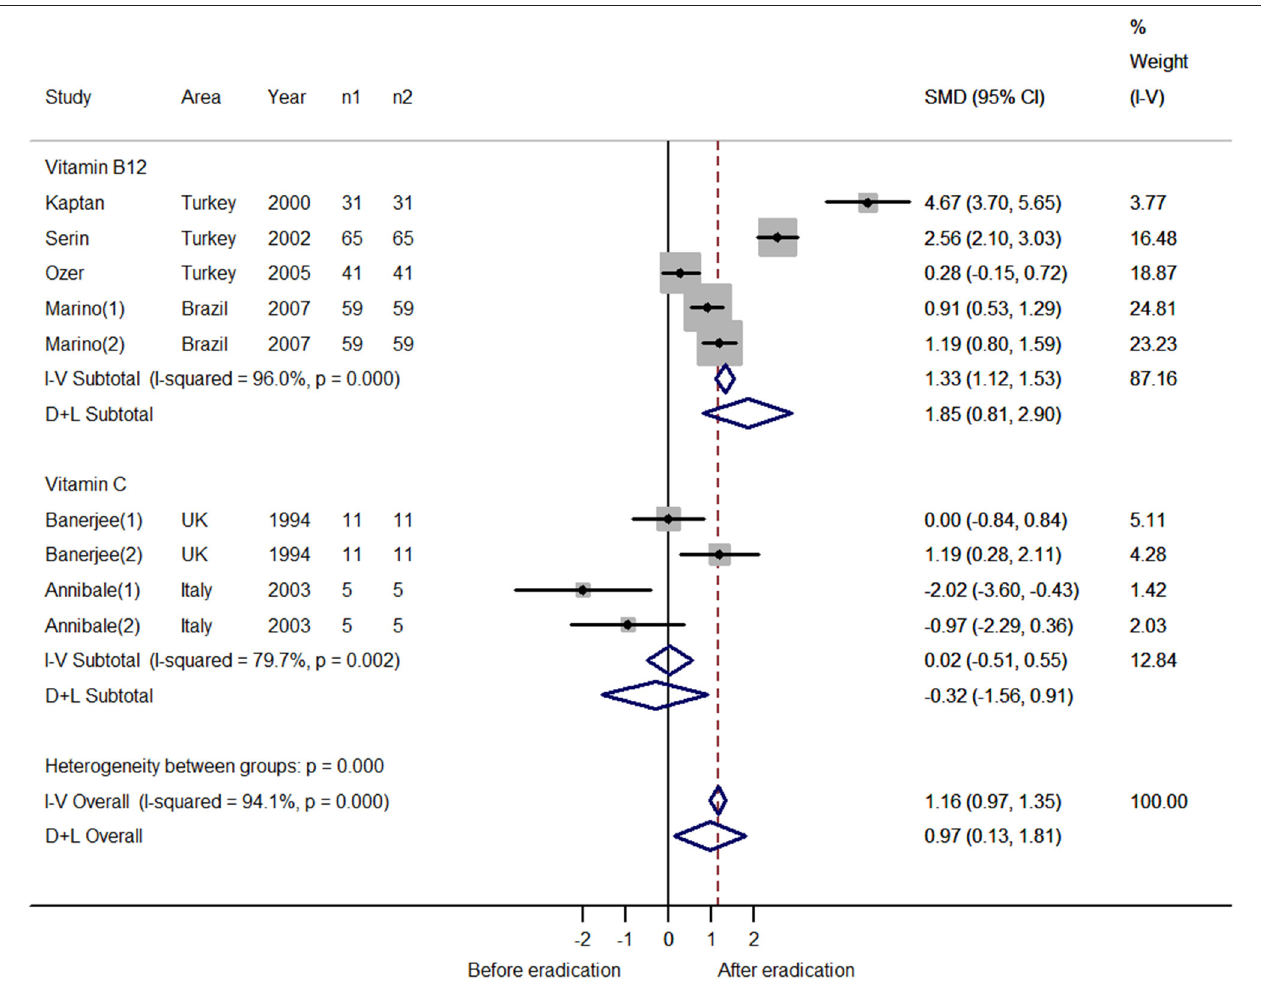
FIGURE 5 | Forest plot of the meta-analysis on the comparison of serum vitamin levels before and after successful H. pylori eradication therapy (n1: number of patients after eradication therapy; n2: number of patients before eradication therapy); After successful H. pylori eradication, serum vitamin B12 increased (SMD = 1.85; 95% CI: 0.81–2.90; P < 0.001; I 2 = 96.0%); H. pylori eradication did not increase the serum vitamin C level (SMD = − 0.32; 95% CI: − 1.56–0.91; P = 0.002; I 2 =